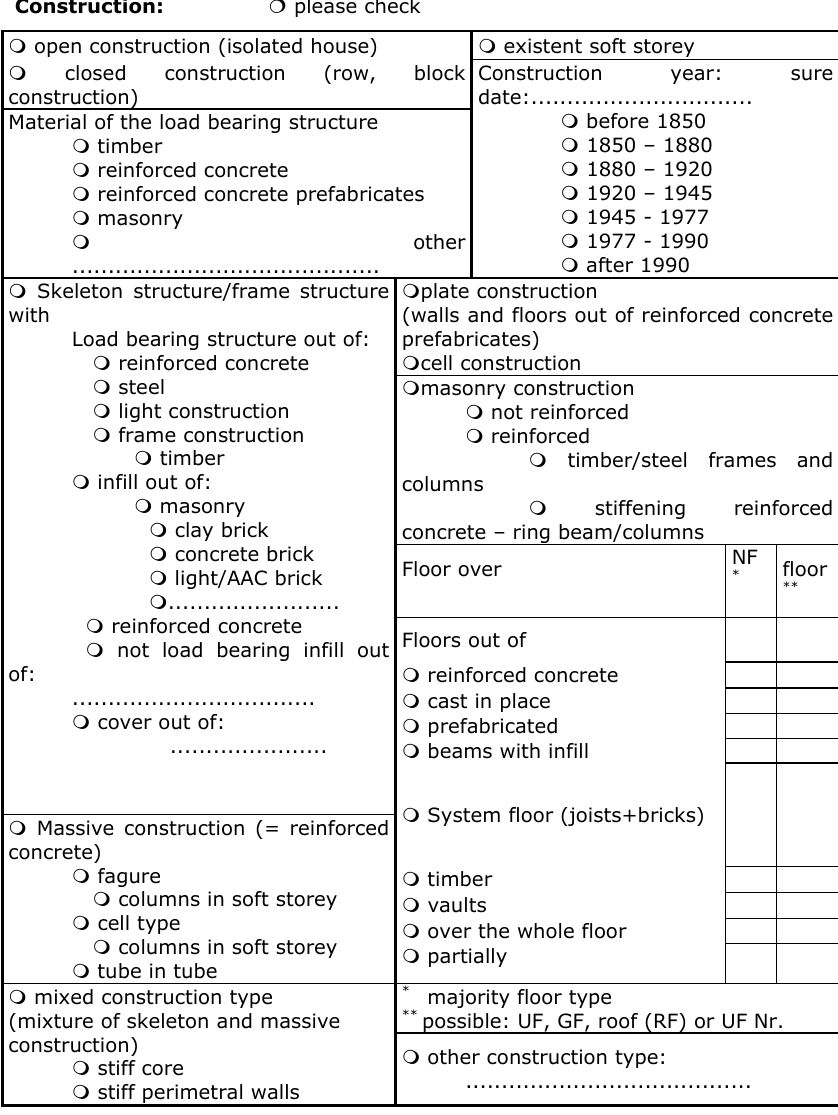
Table 2: List of vulnerable architecturally significant buildings in Bucharest (risk category I) disasters management shall be contained in the master